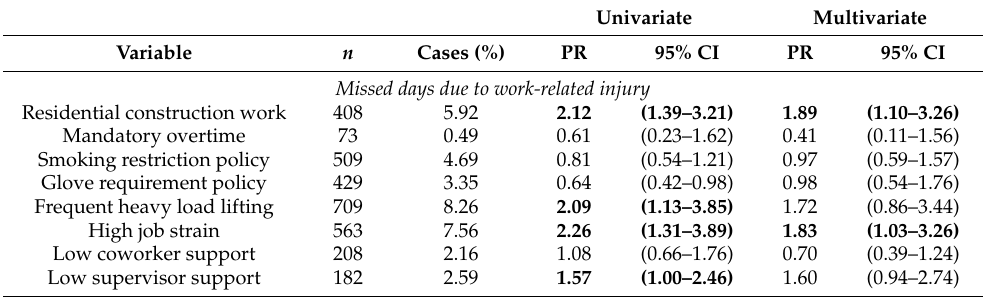
Table 3. Univariate and multivariate associations between work outcomes, health outcomes, health behaviors, and exposure to work factors; n = 929; Prevalence Ratio (PR) and 95% Confidence Interval (CI) were calculated by using Poisson regression, with the same variables included in each